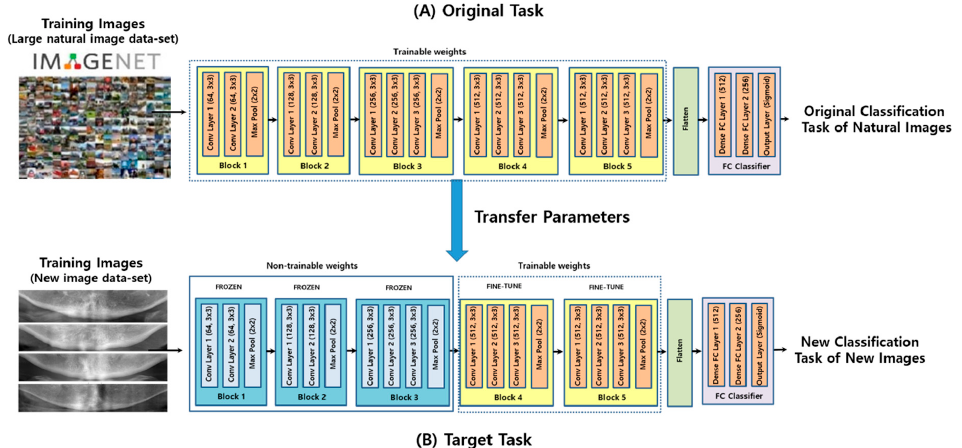
Figure 8 . The conceptual diagram of the fine-tuning technique in the transfer learning of a deep CNN.